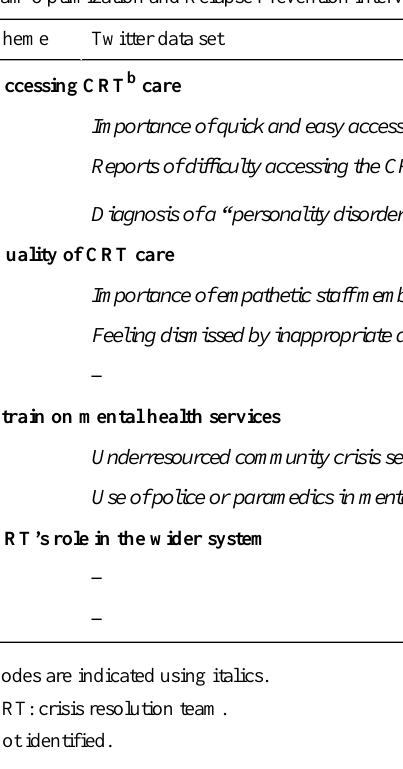
Table 3. Results from the refutational synthesis examining similarities and differences among themes identified in the Twitter data set and the Crisis Team Optimization and Relapse Prevention interview and focus groups data sets, with code examples a